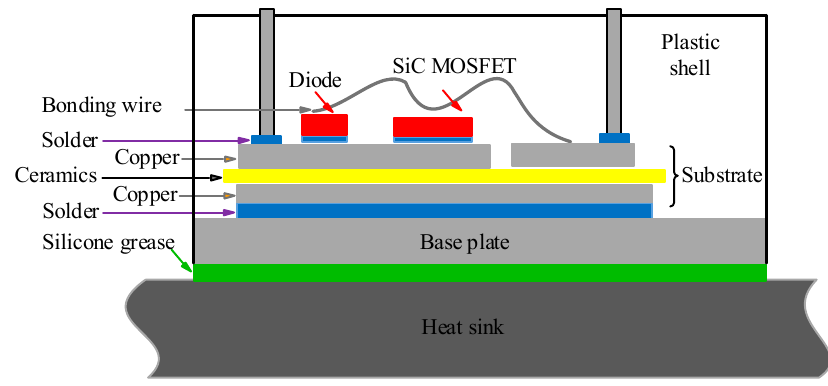
Figure 4. The package of SiC power module.